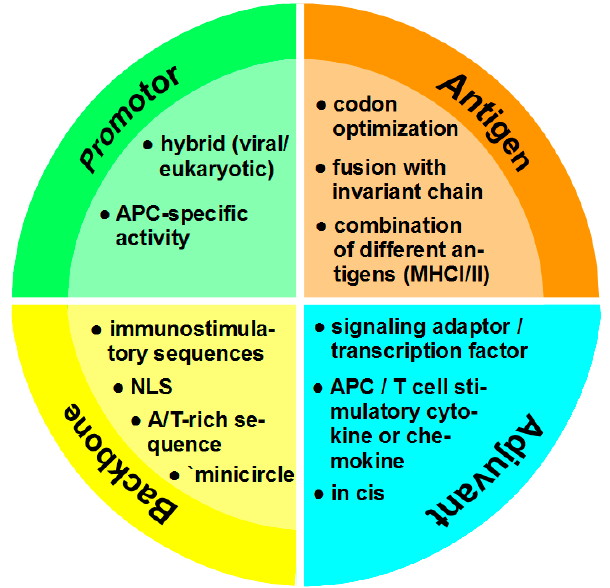
Figure 2. Optimization parameters of DNA vaccine design. Use of a hybrid viral/eukaryotic promoter was shown to prevent transcriptional silencing as observed for viral promotors.